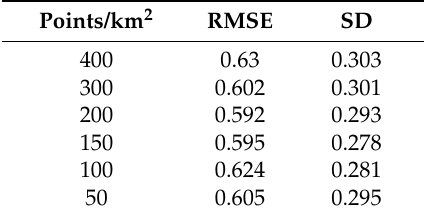
Table 5. RMSE and SD values for the different number of field